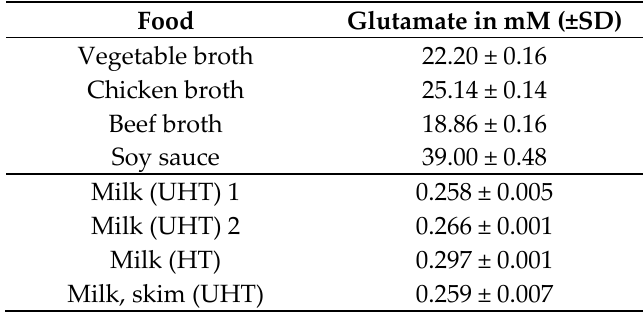
Table 1. Glutamate concentrations (incl. standard deviation) measured in different